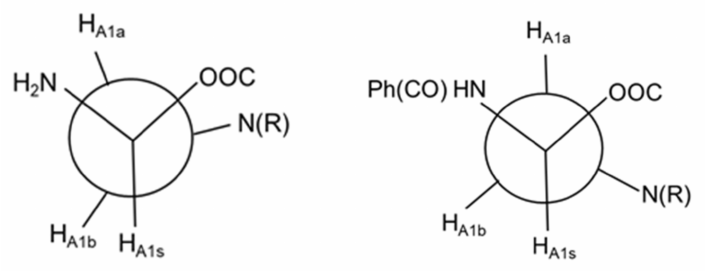
Scheme 4. Newman-projections of conformation along the C 1ab -C 1s bond of the C α -substituted pendant arm of Y(DO3A-ACE) − ( left ) and Y(DO3A-BACE) − ( right